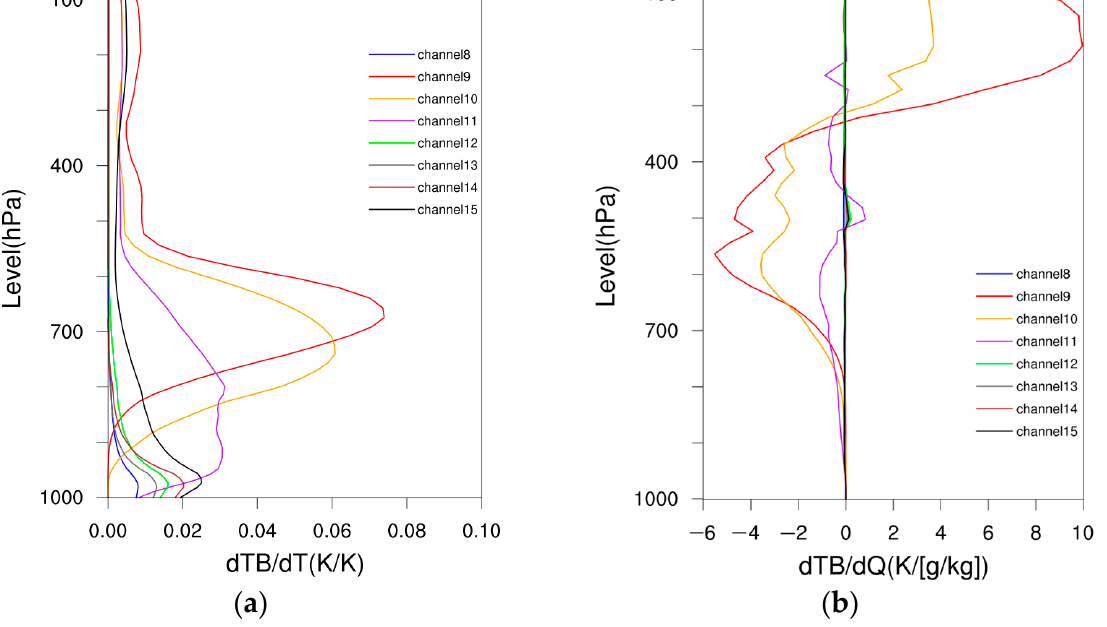
Figure 1. Vertical distribution of Fengyun-4B/AGRI IR channel brightness temperature Jacobians for ( a ) temperature and ( b ) water vapor by using U.S. standard atmospheric profile as input.